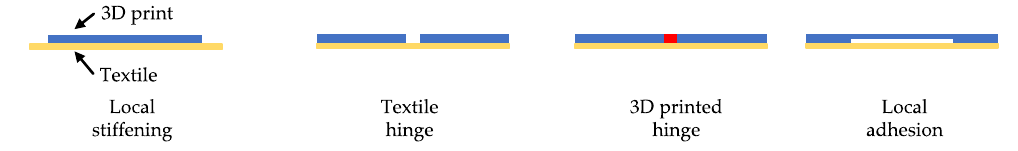
Figure 6. Design primitives for developing 4D textiles.